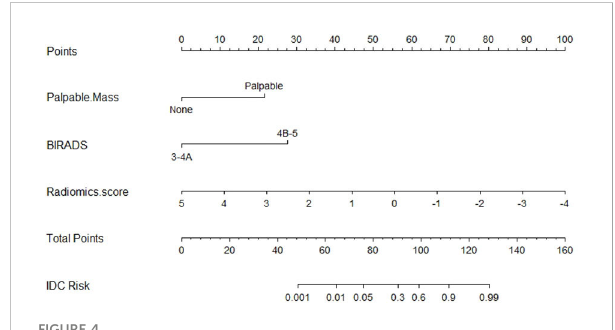
FIGURE 4 The nomogram was established based on the model.